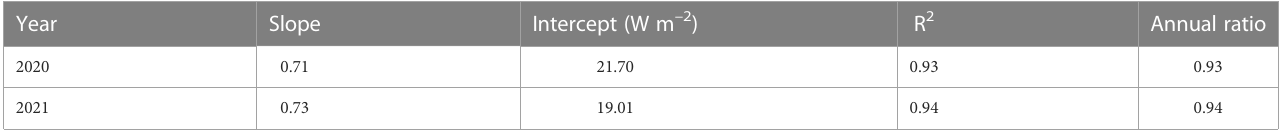
TABLE A1 Characteristics of energy balance and annual ratio of S (LE+H)/ S (R n − G) in 2020 and 2021. R n : net radiation.